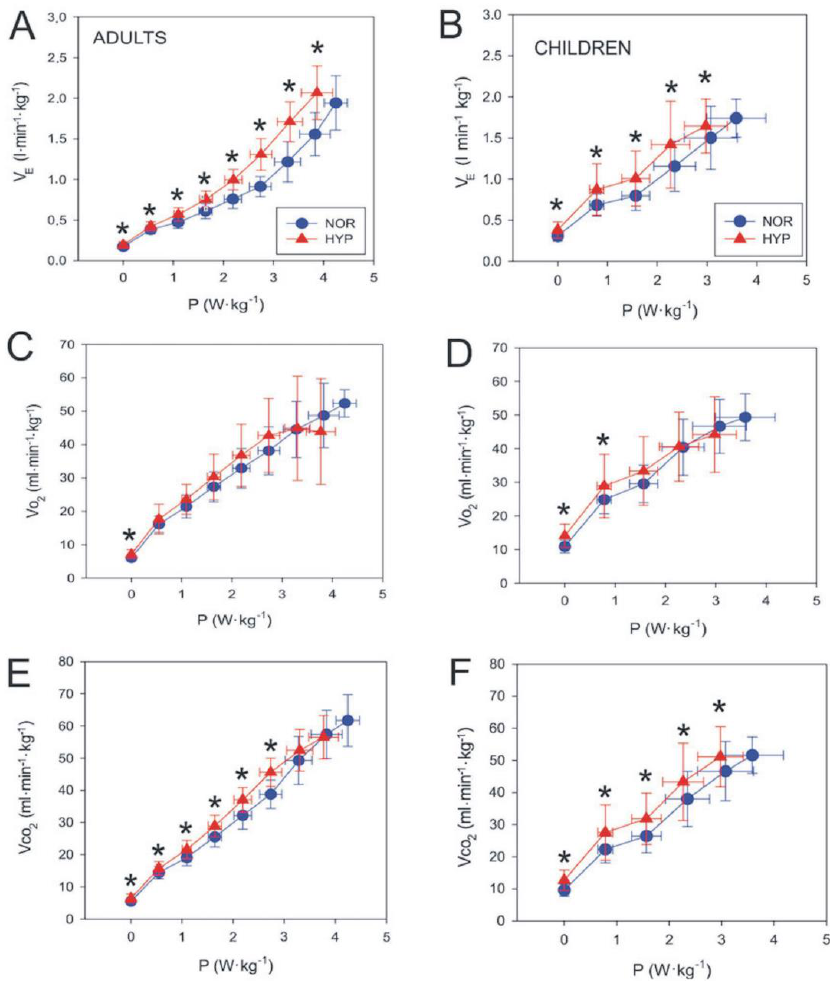
. Figure 1. Resting and exercising values of minute ventilation (V̇ E ; panels ( A , B )), oxygen consump- Figure 1. Resting and exercising values of minute ventilation ( V E ; panels ( A , B )), oxygen consumption . . tion V̇O 2 ; panels ( C , D )) and carbon dioxide output ( V̇CO 2 ; panels ( E , F )) for both adults and children. VO 2 ; panels ( C , D )) and carbon dioxide output ( VCO 2 ; panels ( E , F )) for both adults and children. Values are reported as means (SD). Significant post hoc differences: * ( p < 0.05) denotes significantly Values are reported as means (SD). Significant post hoc differences: * ( p < 0.05) denotes significantly different values compared to NOR. different values compared to NOR. The effects of hypoxia were determined by comparing the differences observed be- tween the NOR and HYP conditions at two distinct exercise intensities: a submaximal in- Table 1. Cardiorespiratory and gas exchange values in adults and children at submaximal intensities tensity, corresponding to the GET in each environmental condition, and a maximal inten- during normoxic (NOR) and hypoxic (HYP) exercise testing sity (MAX). Comparisons with values normalized to body mass were conducted when appropriate.